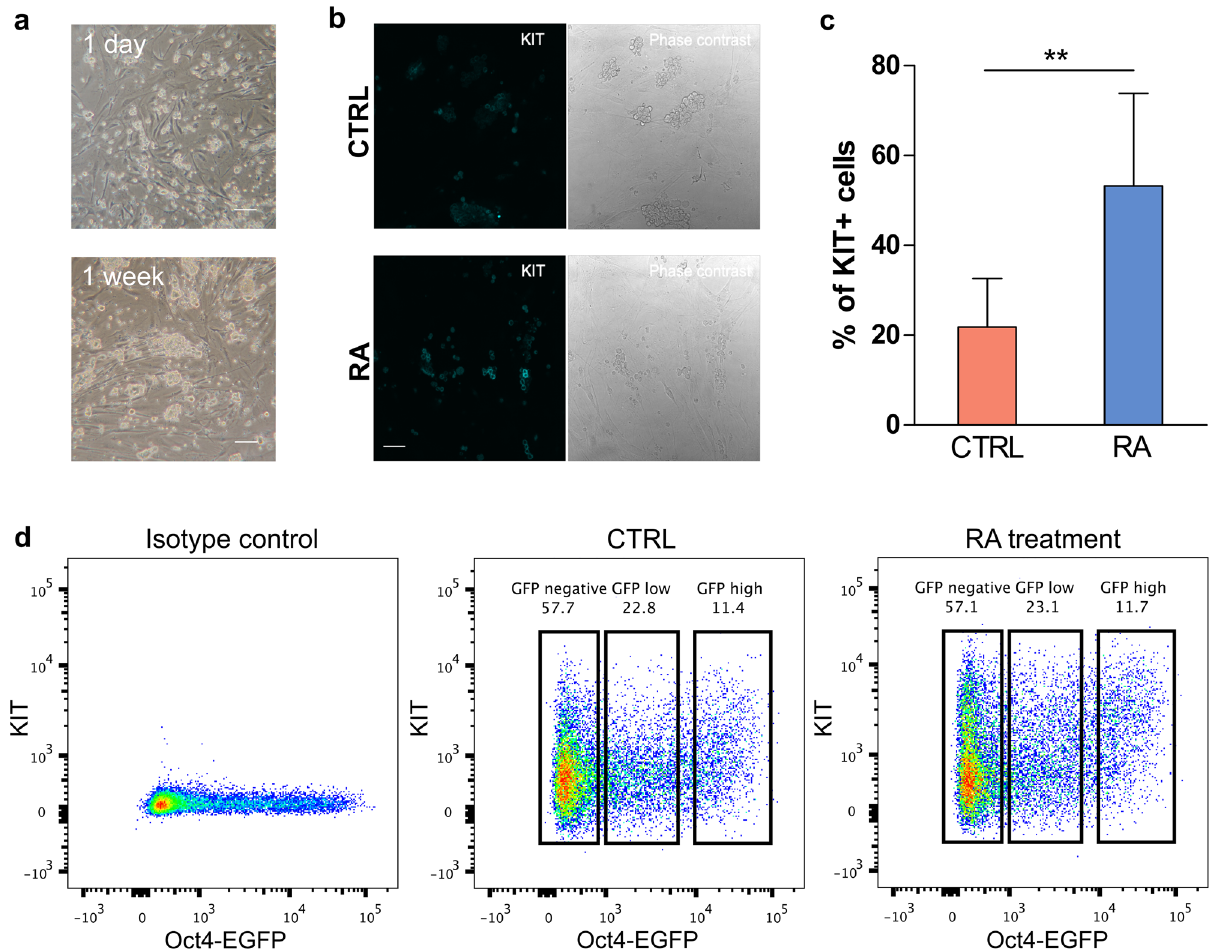
Figure 1. Retinoic acid (RA) induces differentiation in germline stem cells (GSCs) in vitro. ( a ) Bright field images of stabilized germline stem cell (GSC) culture on the MEF feeder layer showing 1 day after subculture (top) and 1 week after subculture (bottom). Scale bars 100 μm. ( b ) Representative phase contrast and immunofluorescence images of control (upper panel) and RA-treated (lower panel) GSC culture stained for KIT. Scale bars 50 μm. ( c ) Quantification of KIT + cells in RA-treated and control GSCs by flow cytometry analysis (P < 0.01, n = 6). Error bars indicate SD. Significance was determined by an unpaired two-tailed t-test. ( d ) Flow cytometry analysis of Oct4-EGFP and KIT levels in GSCs treated with 0.5 μM RA for 24 h, DMSO control and unstained isotype control. Cells were stained with mouse anti-KIT-APC